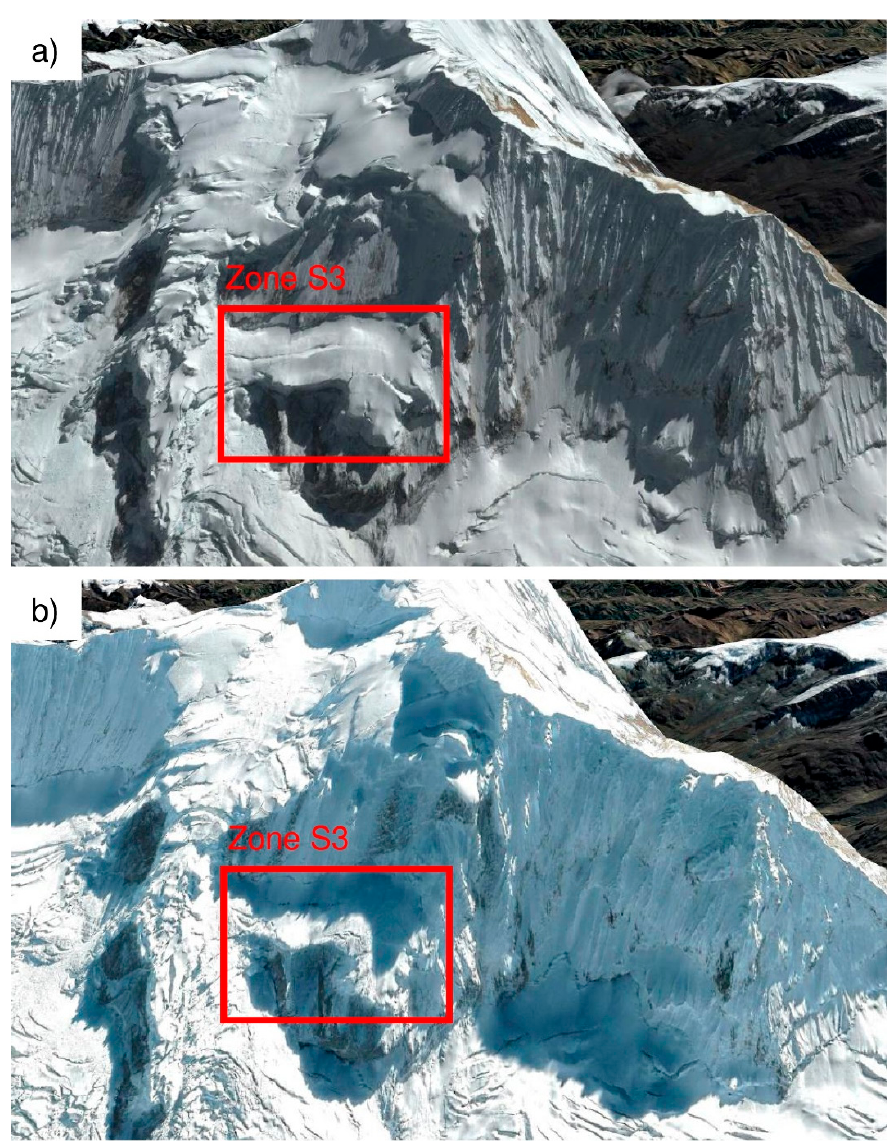
Figure 8. Satellite image of Zone S3 on ( a ) 20 August 2013 and ( b ) 3 July 2020 (Google